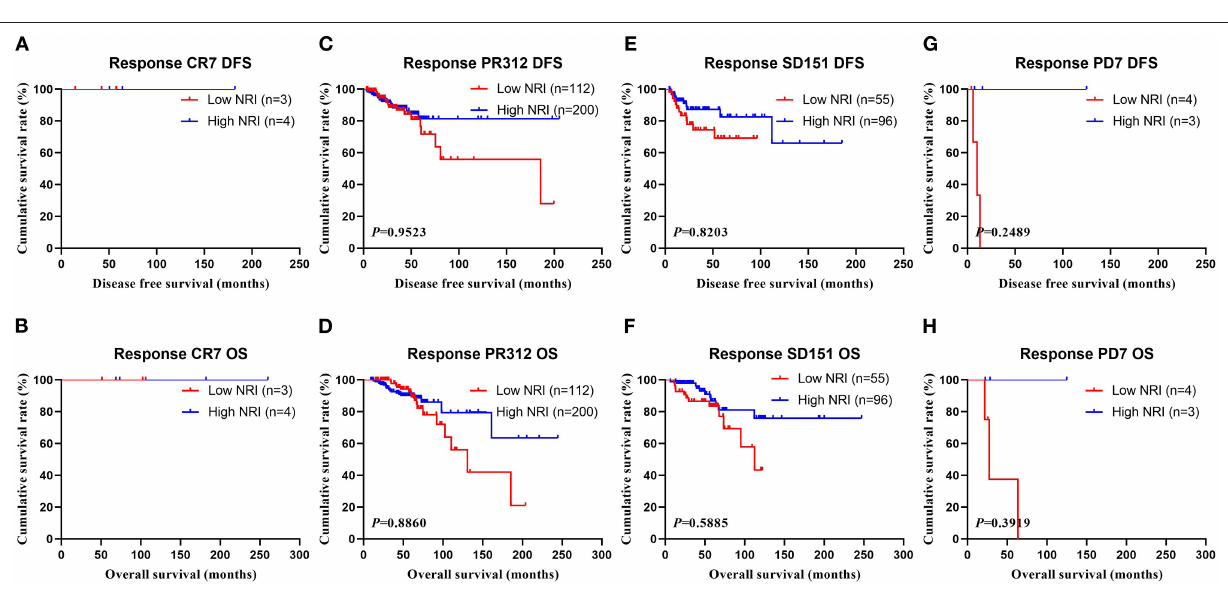
FIGURE 6 | DFS and OS for the NRI of breast cancer patients in response in NACT group. (A) Kaplan-Meier analysis of DFS of patients with response CR, (B) Kaplan-Meier analysis of OS of patients with response CR, (C) Kaplan-Meier analysis of DFS of patients with response PR, (D) Kaplan-Meier analysis of OS of patients with response PR, (E) Kaplan-Meier analysis of DFS of patients with response SD, (F) Kaplan-Meier analysis of OS of patients with response SD, (G) Kaplan-Meier analysis of DFS of patients with response PD, (H) Kaplan-Meier analysis of OS of patients with response